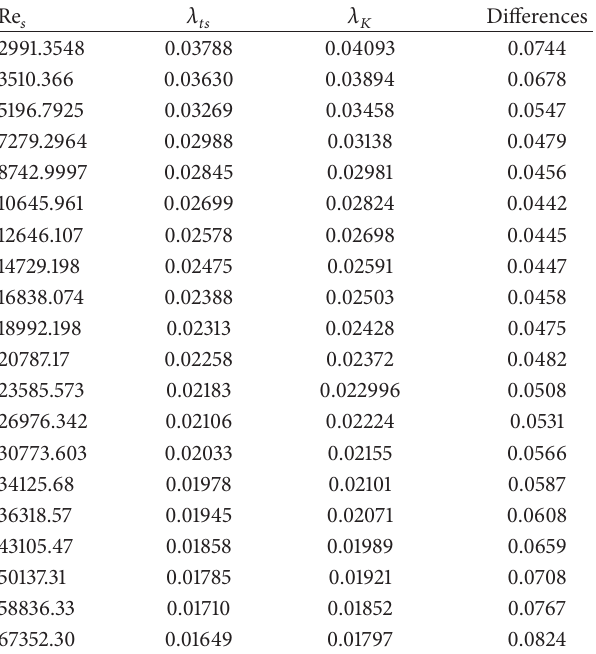
Table 1: Comparison of 𝜆 𝑡𝑠 and 𝜆 𝐾